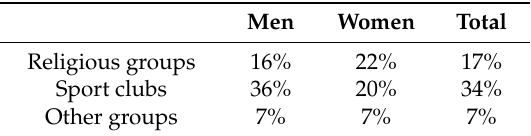
Figure 4. Agreement to the statement “When jobs are scarce, men should have more rights to a job than women”. Source: DiPAS#1 ( n = 514 persons). Table 2. Involvement in religious groups, sports clubs and other groups or organizations, by